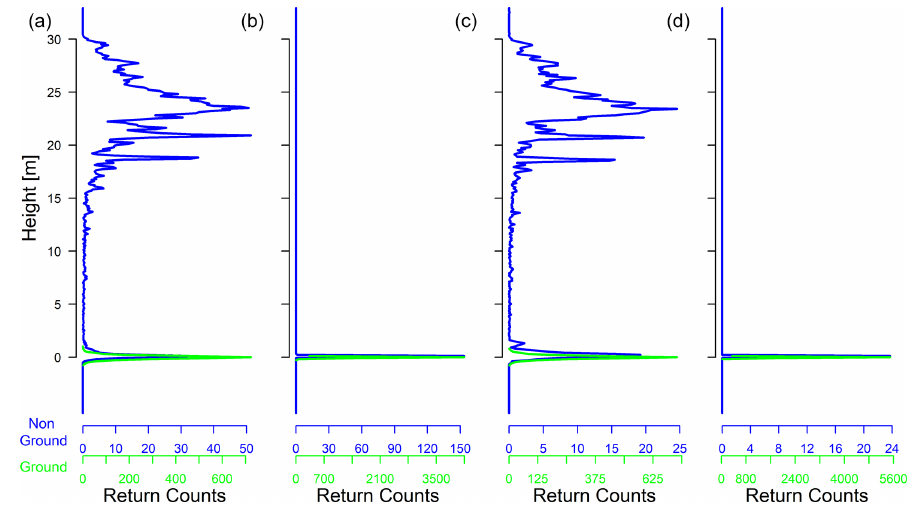
Figure 4. Mean height profiles for all ground (green) and non-ground (blue) lidar returns within a 5m × 5m region centered on each transect plot in snow-free conditions (a, b) and snow-on conditions (c, d) in forest (a, c) and field (b, d) study